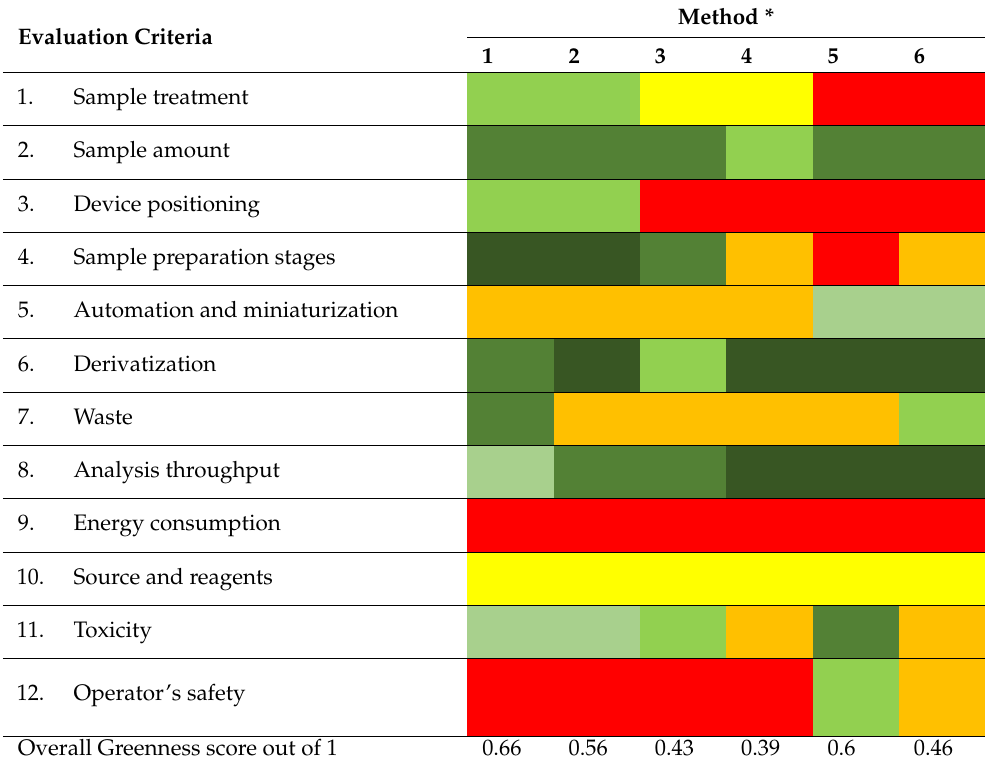
Table 2. Comparison of greenness of methods based on AGREE tool